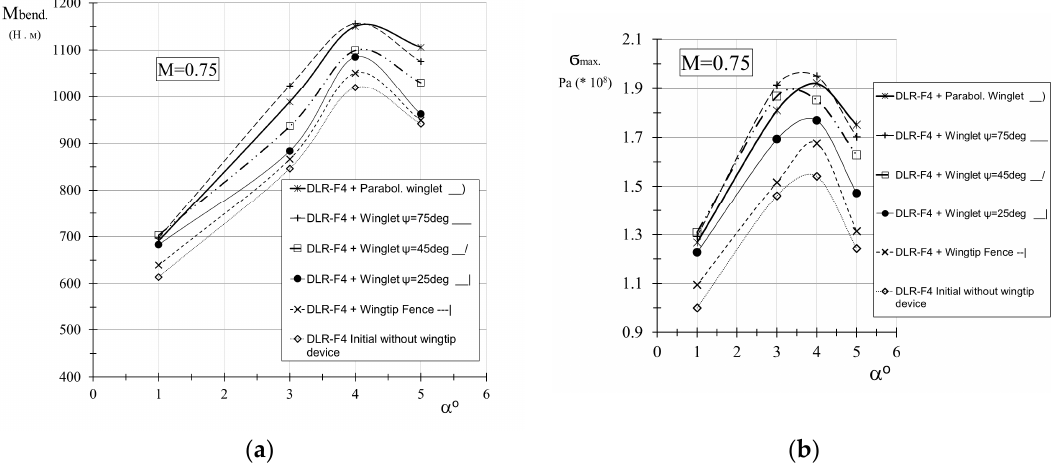
Figure 20. ( a ) DLR-F4 wing root bending moment (WRBM) values for different-configuration winglets and wingtip fence; ( b ) Values of the maximum equivalent Von Mises stress depending on the geometric angle of attack of DLR-F4 model equipped with different wingtip devices.